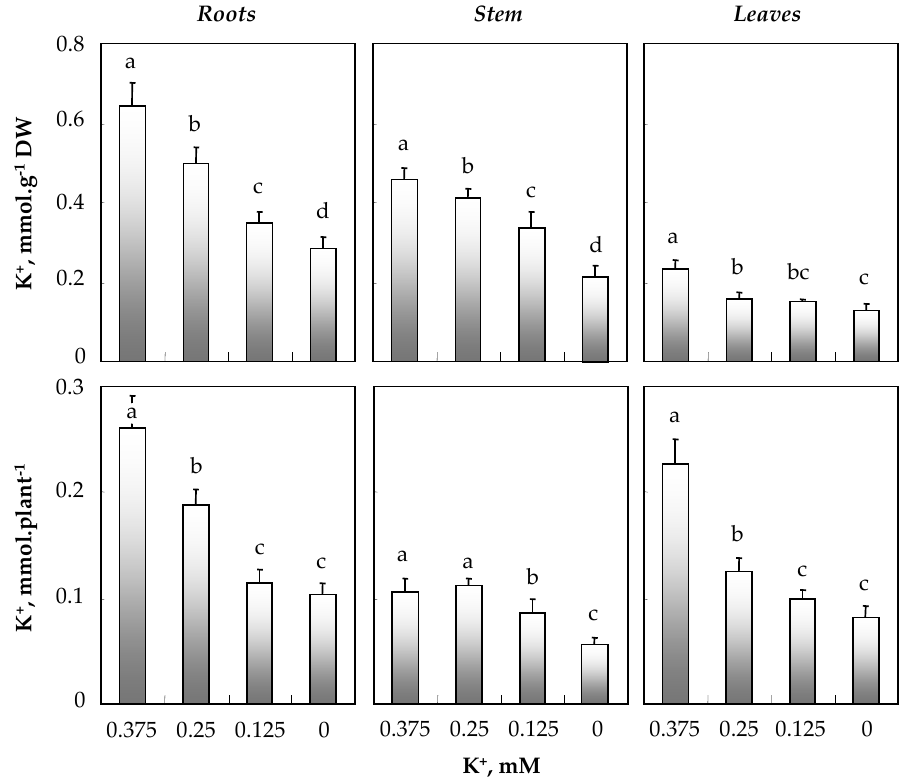
Figure 4. Variations in K + concentrations and amounts in roots, stems and total leaves of 64-day-old O. basilicum plants grown for 30 days in the presence of varying K + concentrations (0.375, 0.25, 0.125 and 0 mM). Cf. leg. Figure 2.